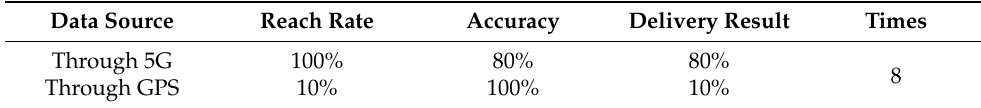
Table 16. Comparison of delivery effectiveness on school students.